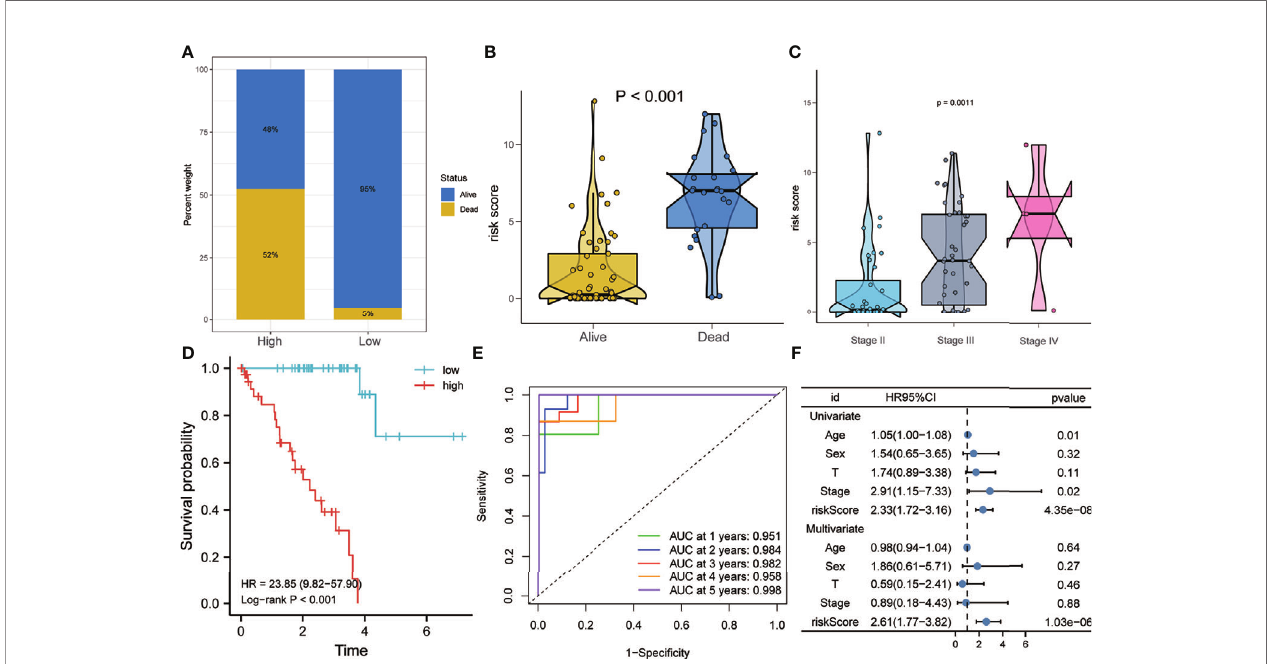
FIGURE 4 | Risk score predicts poor survival in the training set. (A) Patients in the high-risk group had a higher mortality rate. (B) Patients who died during follow- up had higher risk scores. (C) More advanced tumor stages had higher risk scores. (D) Kaplan – Meier analysis showed that patients with higher risk scores had worse overall survival. (E) The receiver operating characteristic (ROC) curve showed that the risk score exhibited good predictive ef fi ciency for OS (AUC > 0.9). (F) Univariate and multivariate Cox regression analyses showed that risk score was an independent risk factor for OS. AUC , area under the ROC curve; HR , hazard ratio; OS , overall